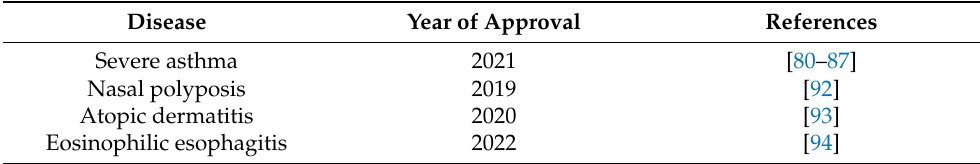
Table 3. Approved indications for the therapeutic uses of